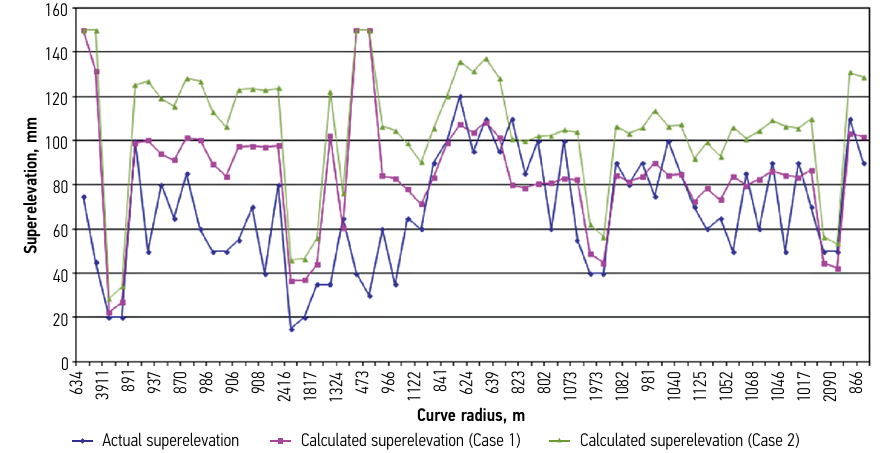
Fig. 2. Superelevation in the curves following the line Vilnius–Kena: Case 1 – v = 0.8· v max ; Case 2 – v = 0.9· v max